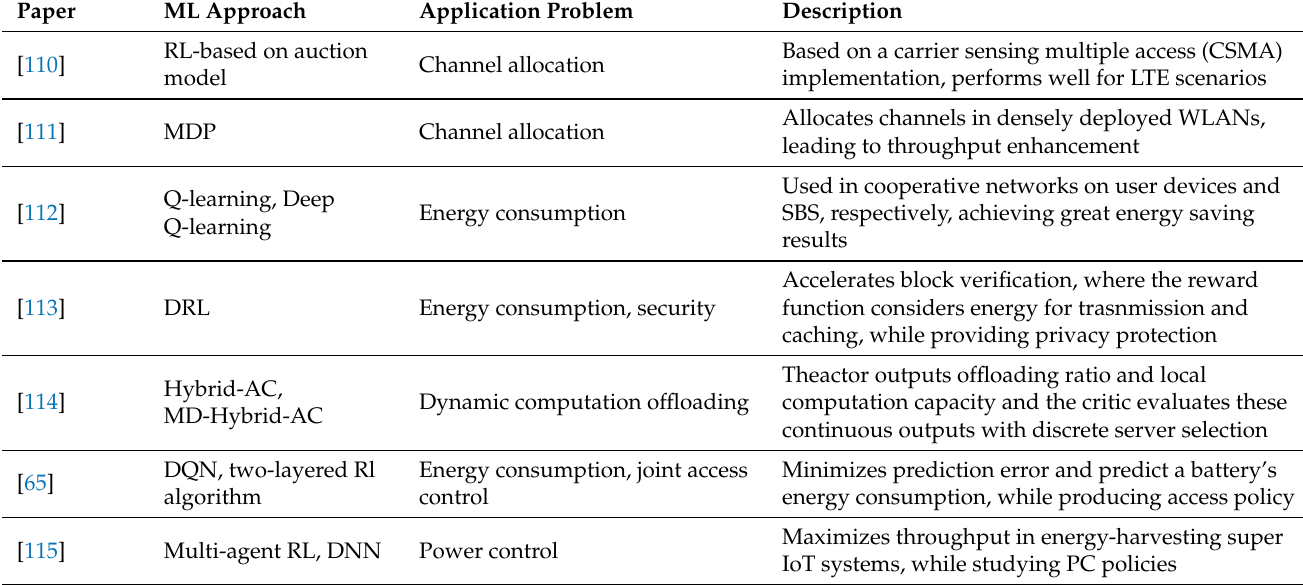
Table 9 holds a brief summary of the RL models used in various 6G problems. Table 9. RL models in 6G various